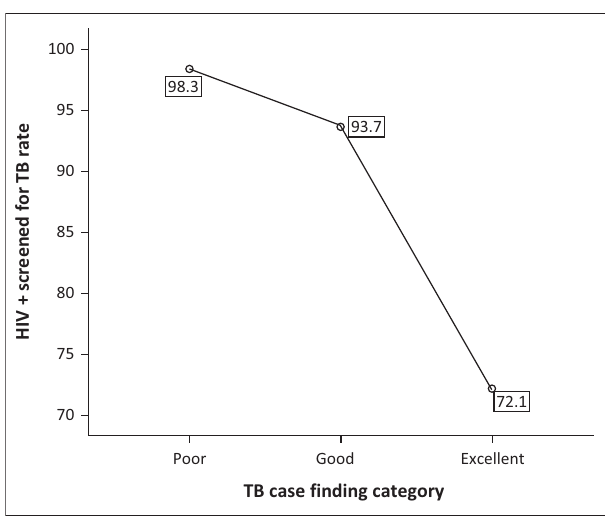
FIGURE 4: Average HIV + patient screened for tuberculosis rate by the tuberculosis case finding and management service area quality